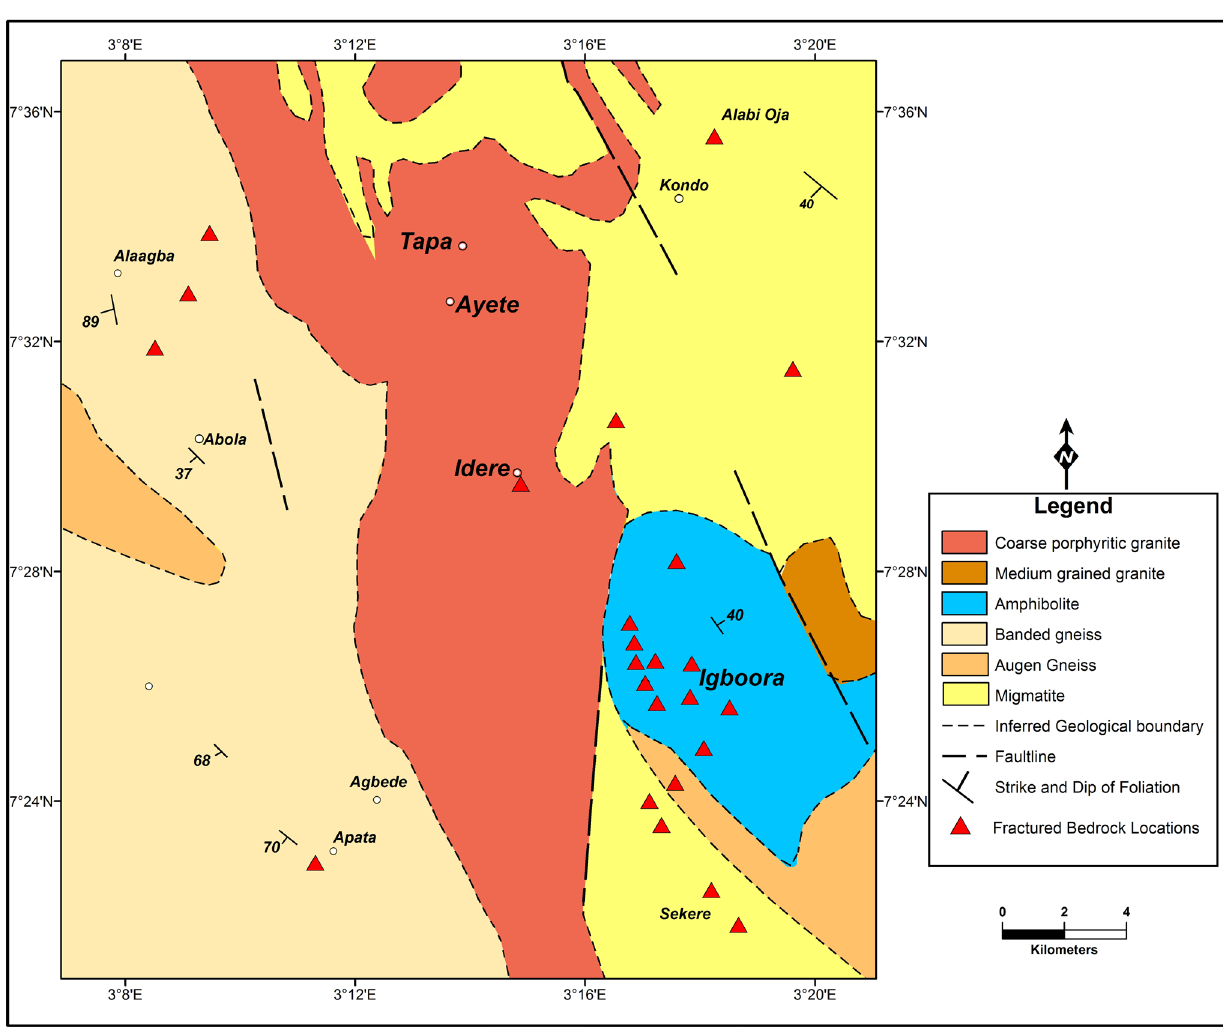
Fig. 9 Fractured bedrock locations on geological map of the study